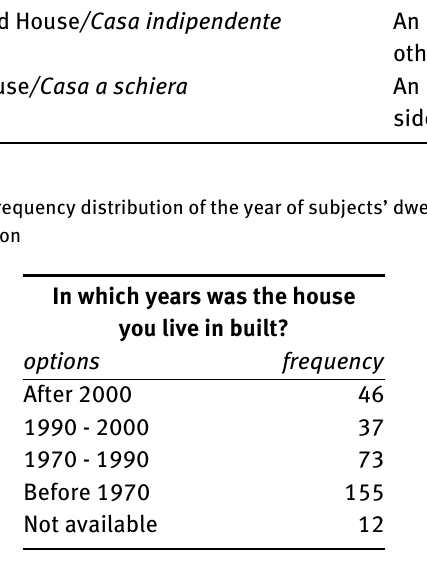
Table 8: Frequency distribution of the acoustic improvements of the dwellings